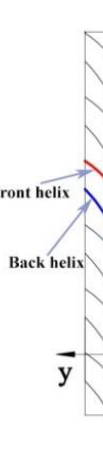
Figure 4. Helix spread of the screw rotor.